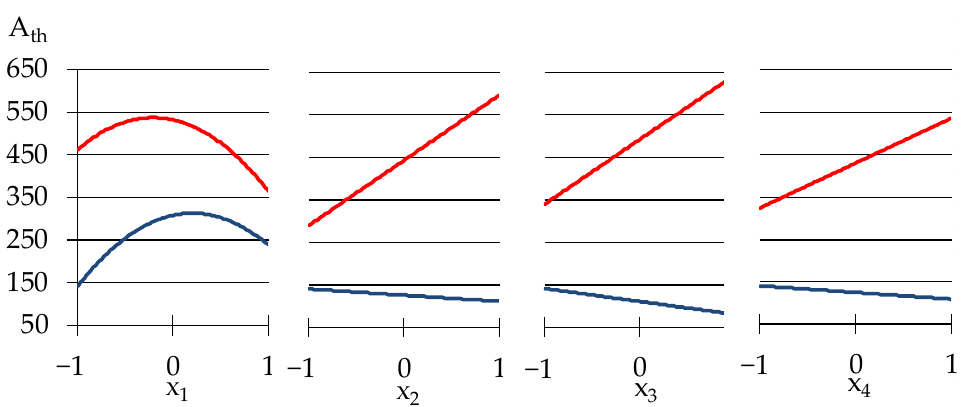
Figure 6. The influence of composition factors on the thixotropy of the mortars.